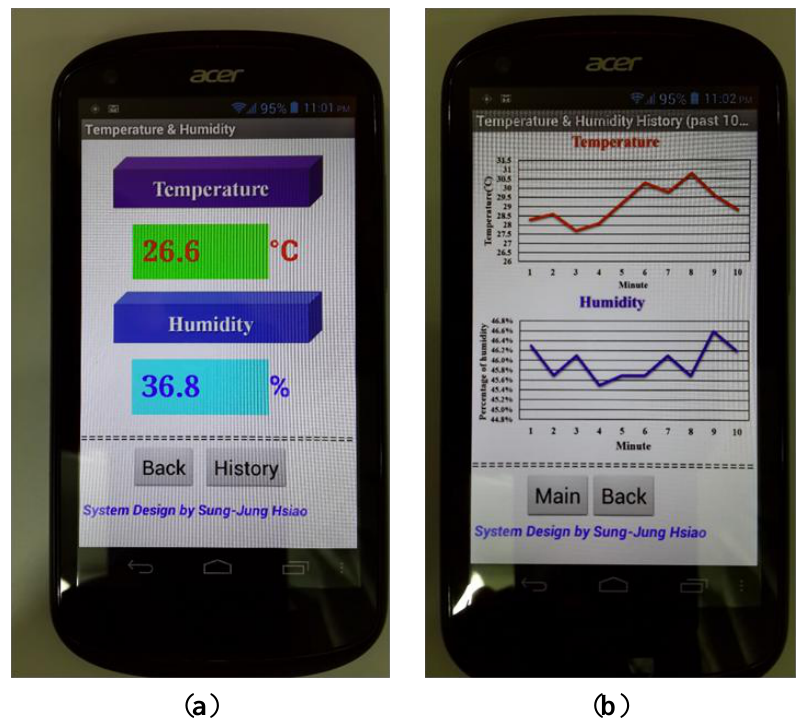
Figure 14. Employing android app methods to link temperature and humidity real-time information. ( a ) Temperature and humidity; ( b ) past 10 min history